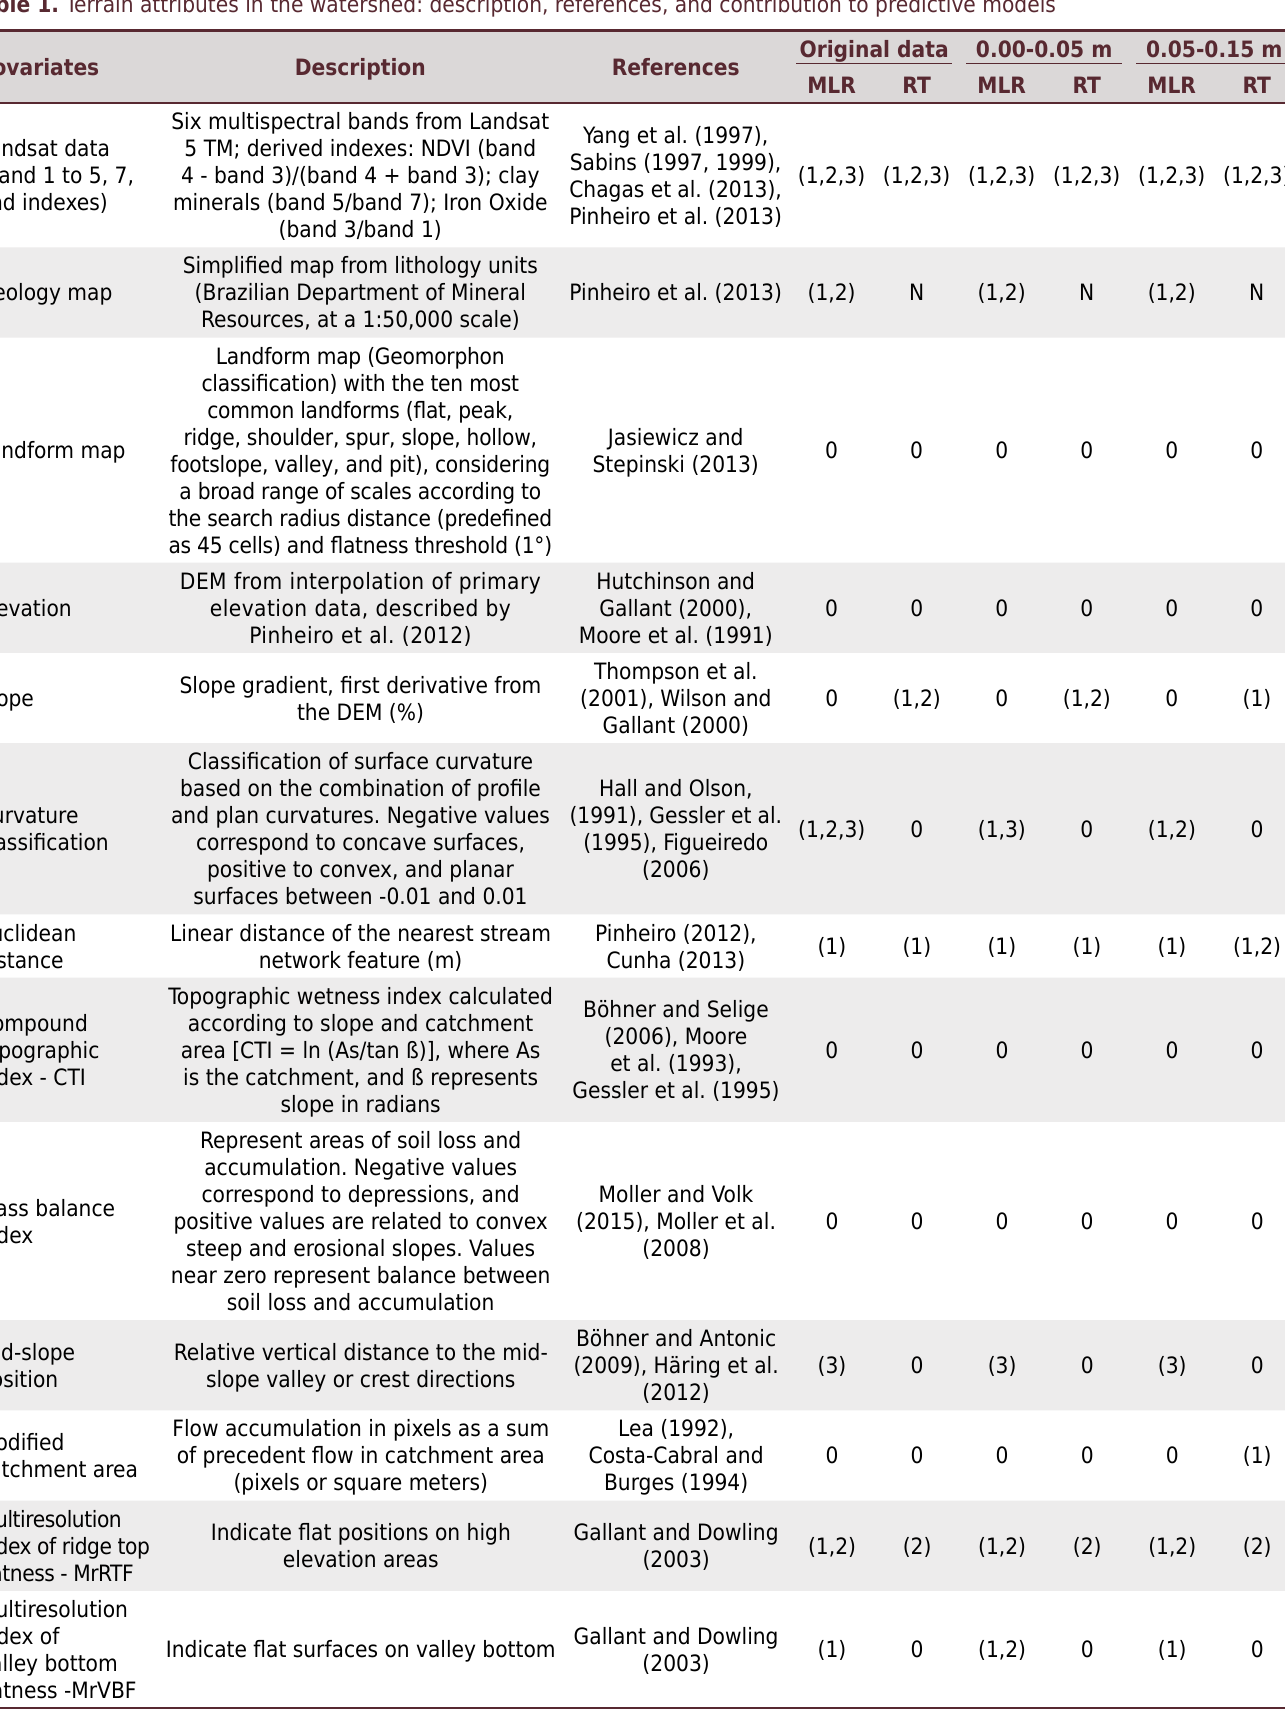
Table 1. Terrain attributes in the watershed: description, references, and contribution to predictive models